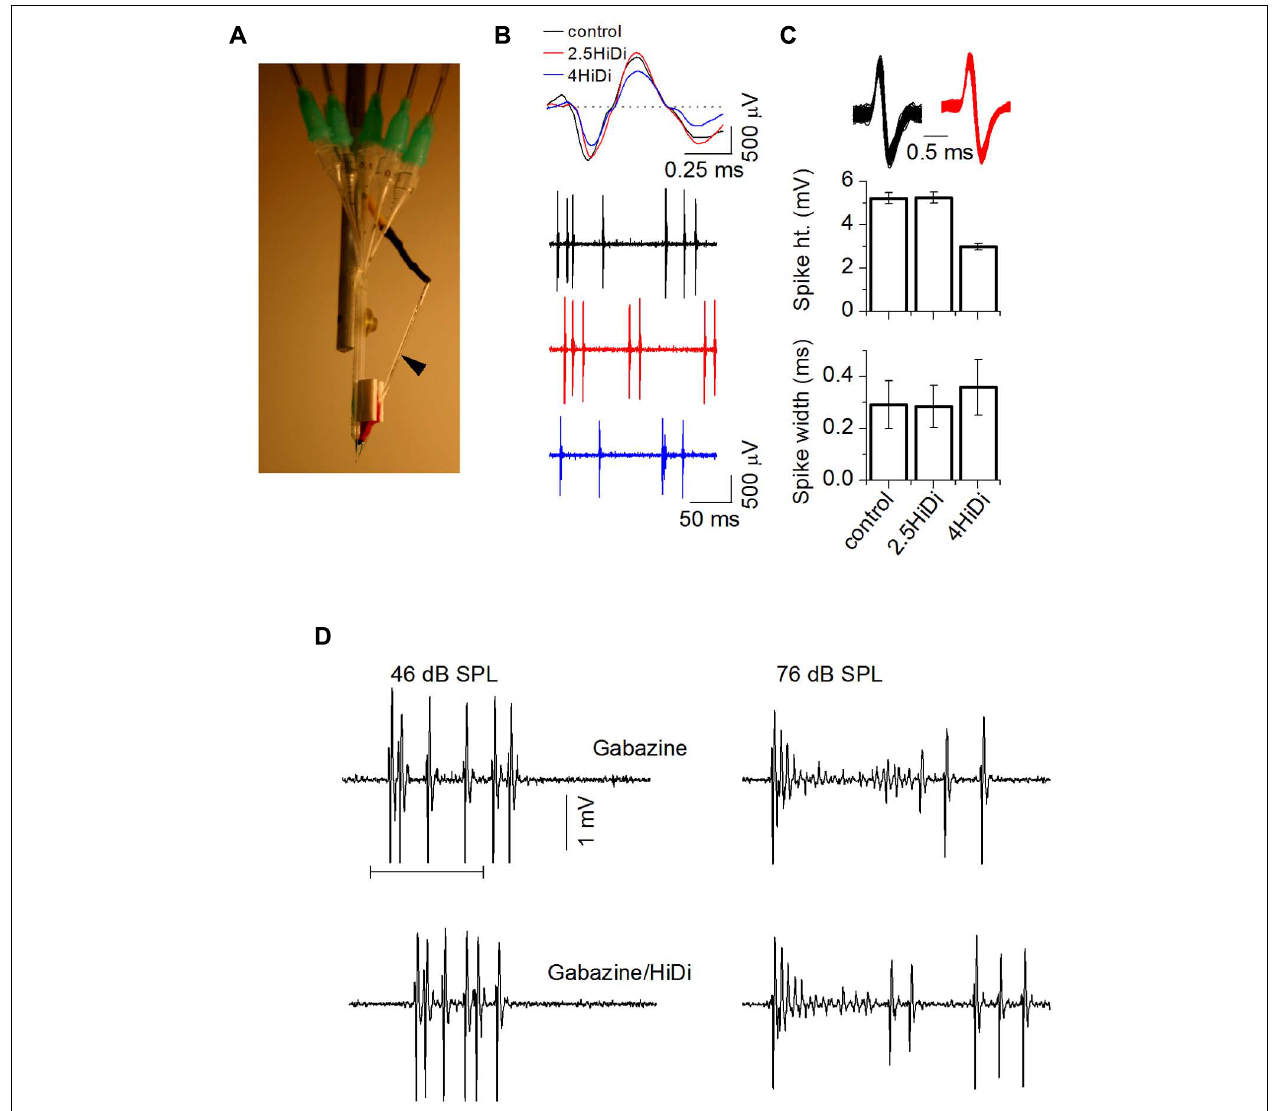
FIGURE 5 | Establishing optimal HiDi concentrations in vivo . (A) Multi-barrel system for pressure injection and attached recording electrode (arrow). Pressure tubes are inserted into each barrel. (B) Spikes during single unit recordings were normal in 2.5 HiDi but shortened and broadened in 4 HiDi. Left: recordings of spiking in control, 2.5 HiDi and 4 HiDi.Top panel: superimposed traces of single tone-evoked spikes. Second through fourth traces: snippets of background activity in the absence of tones.The 50 ms scale bar applies to the second through fourth traces. (C) Quantification of HiDi-induced changes in spike heights and widths.Top: superimposed spikes from one neuron in control (black) and HiDi (red) illustrate that single unit isolation is unaffected by the pressure application of HiDi. Recordings illus- trated are at 81 dB SPL, suggesting that changes in spike rates in HiDi at high intensities were not due to false positives or false negatives. Bottom panels: